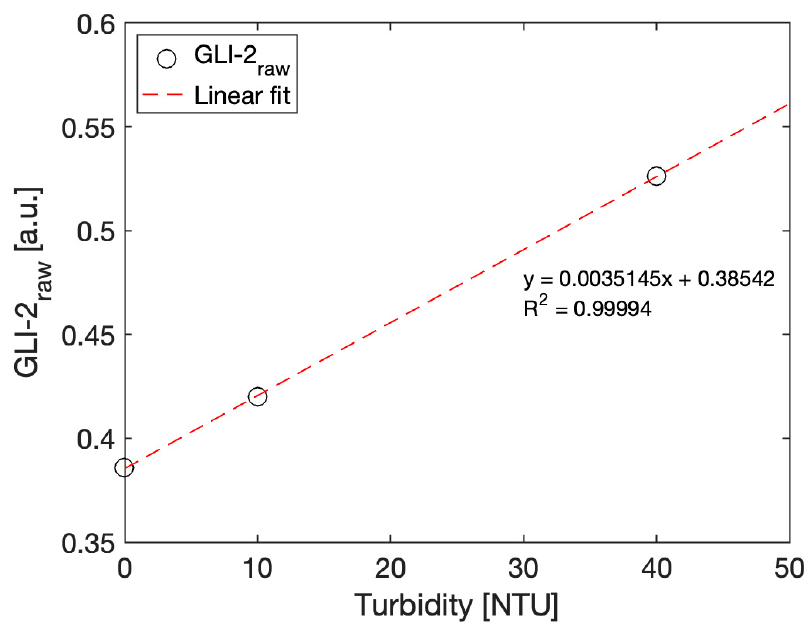
Figure 9. Three-point calibration of the sensor. GLI-2 raw values are calculated from the Active1, Active2, Reference1, and Reference2 signals according to Equation (1) against three calibration solutions of 0 (deionized water), 10, and 40 NTU (Formazin dilutions).